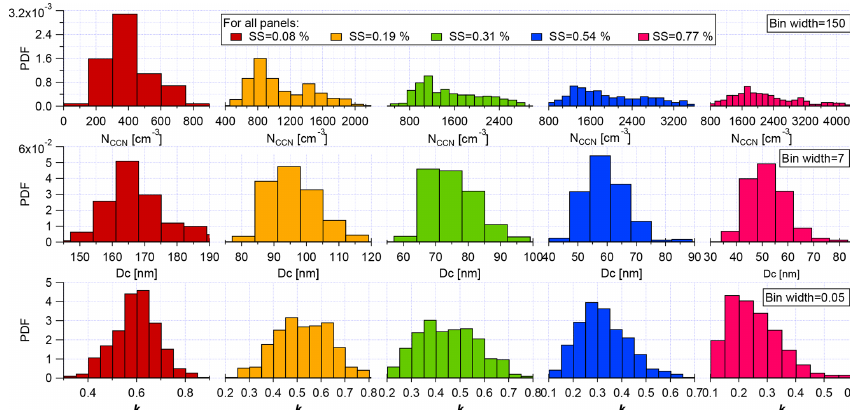
Figure 8. PDFs of N CCN , d crit , and κ values at different